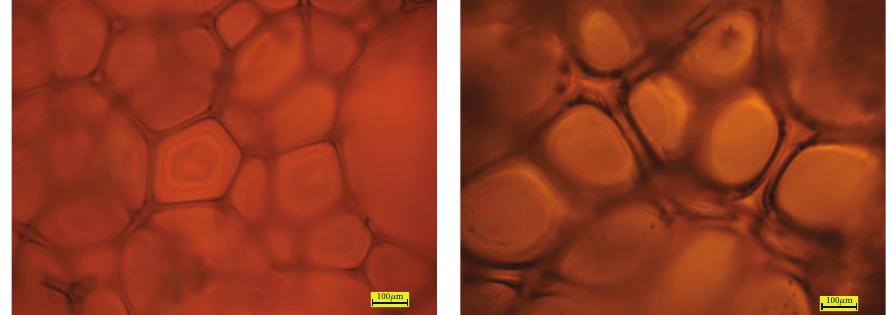
Figure 3: Morphology of foams: (a) FA1 and (b) FB1, magnification 10x.